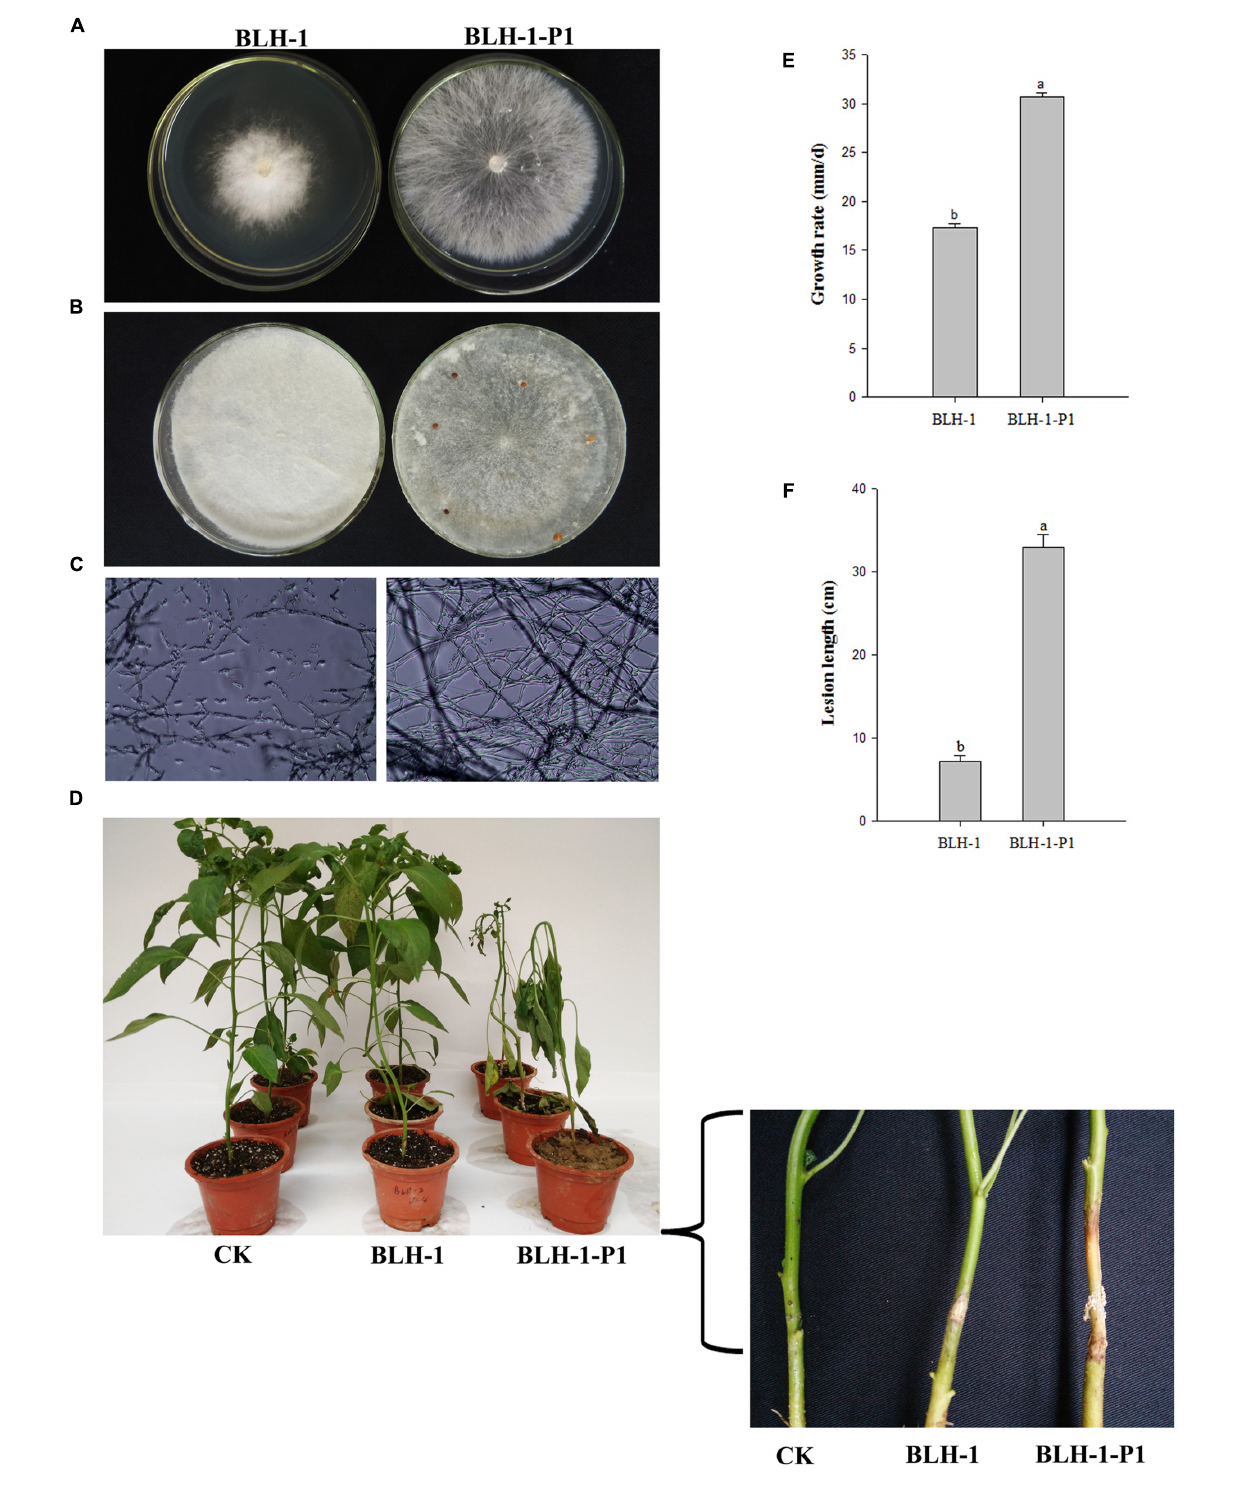
FIGURE 3 | Biological properties of Sclerotium rolfsii strain BLH-1 and its dsRNA-free derivative strain BLH-1-P1. (A) Colony morphology of strains BLH-1 and BLH-1-P1 grown on PDA for 5 days at 27 ◦ C. (B) Sclerotia were produced in strain BLH-1 instead of BLH-1-P1 when cultured for 14 days. (C) Microscopy morphology examination of the 5-day-old hyphae of strains BLH-1 and BLH-1-P1. The pictures are captured at 400 × magnification (D) Virulence assay on pepper ( Capsicum annuum ). The stems near the roots of the pepper plant seedlings were needle-pricked and inoculated by mycelial plugs. The morbidity situation was photographed after inoculation at 27 ◦ C for 5–8 days. (E) Average mycelial growth rates of strains BLH-1 and BLH-1-P1 on PDA at 27 ◦ C. (F) Average lesion length caused by strains BLH-1 and BLH-1-P1 on pepper seedling stems.